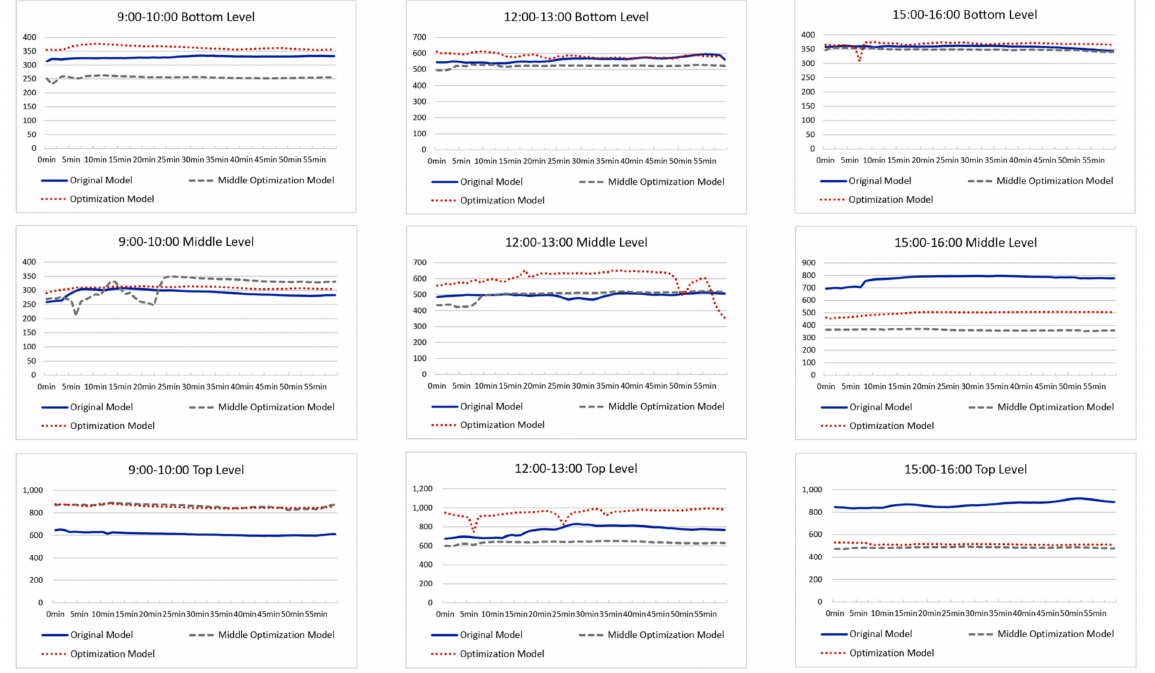
Figure 26. The comprehensive comparison of original, optimized, and best-optimized